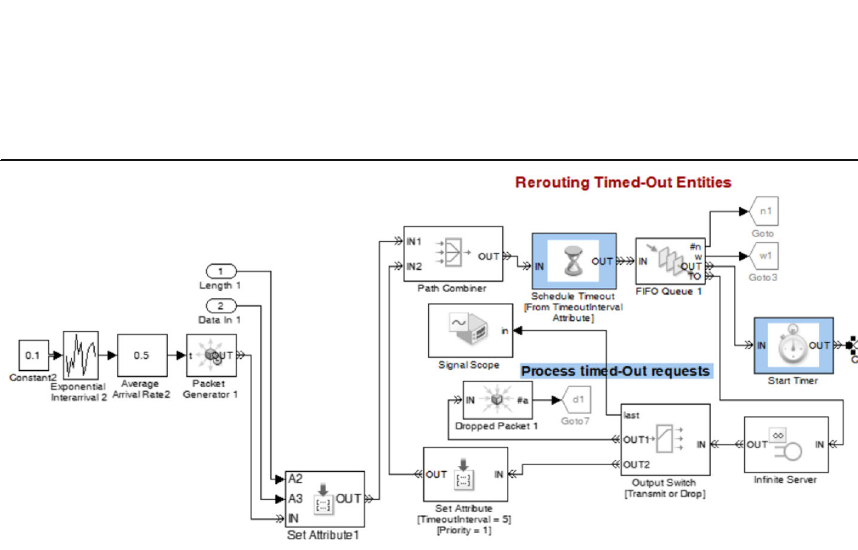
Fig. 7 Snapshot of one traffic source as implemented in MATLAB Simevent